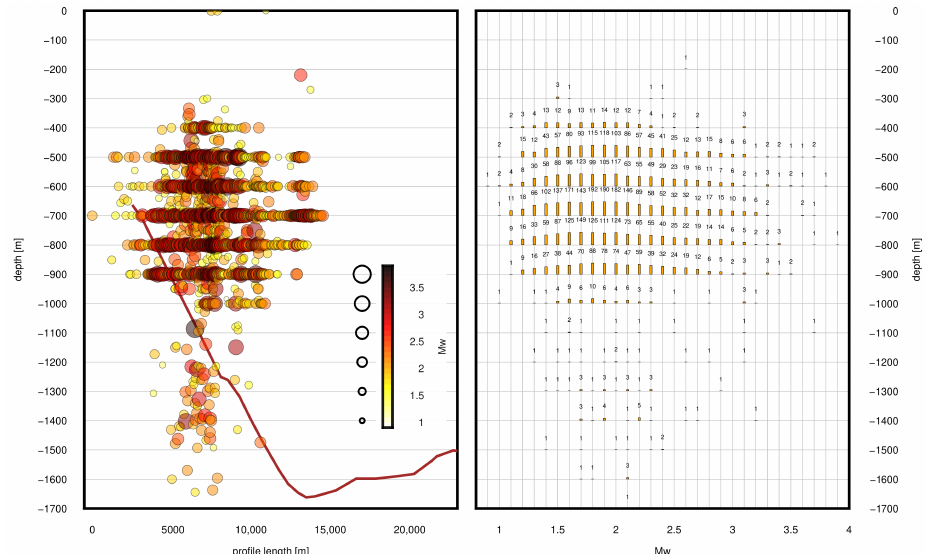
Figure 6. Location (depth) of the induced seismic events along the selected profile (Figure 5): the red line represents the exploited copper deposit (left). On the right: summary of the number of tremors in terms of the depth of